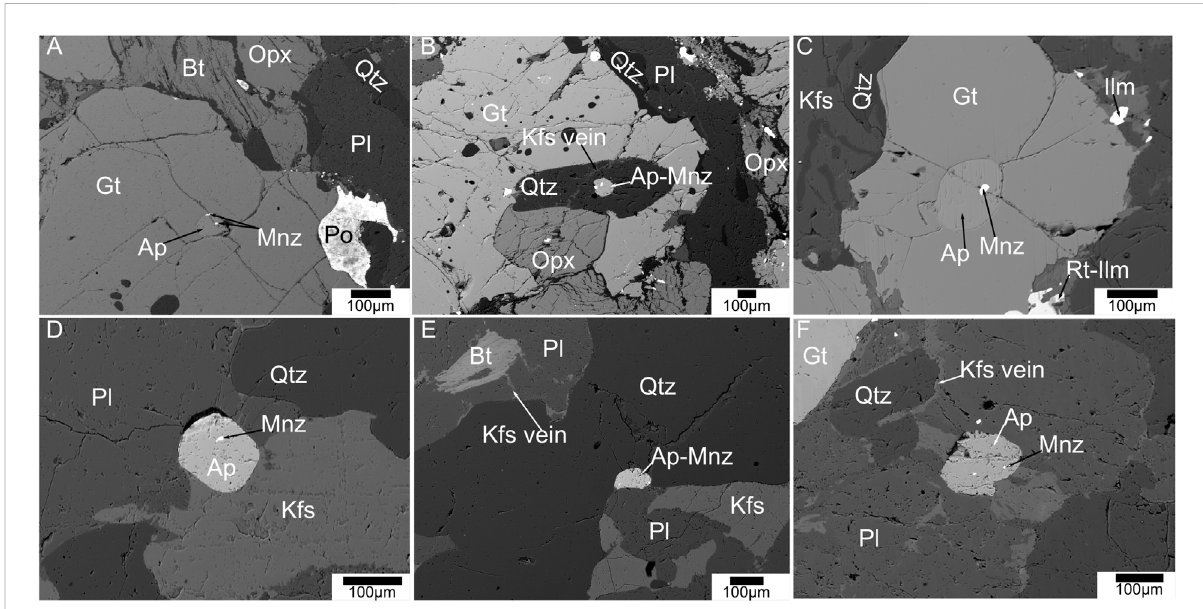
FIGURE 3 Back scattered electron images of equilibrium mineral assemblages and their textures in charnockite samples. Apatite grains with monazite blebs (A) within garnet; (B) near K-feldspar vein passing through quartz grains; (C) within garnet; (D – F) near K-feldspar veins in matrix of plagioclase and